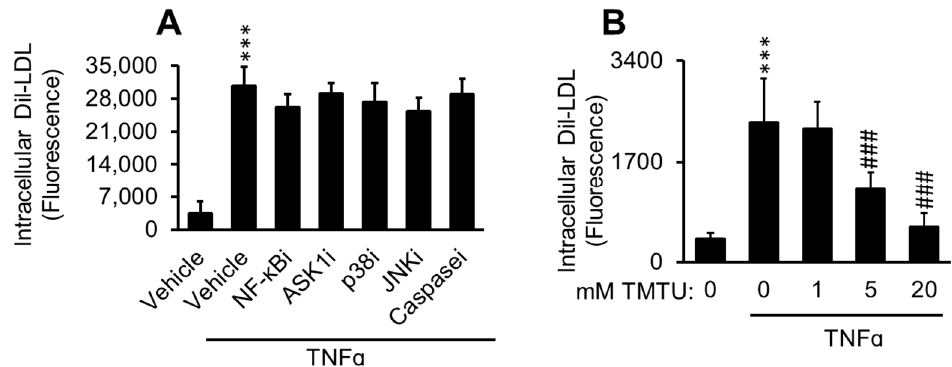
Figure 10. Antioxidant suppresses TNF ɑ -induced Dil-LDL accumulation. ( A ) pHAECs were pre-treated with 0.05%